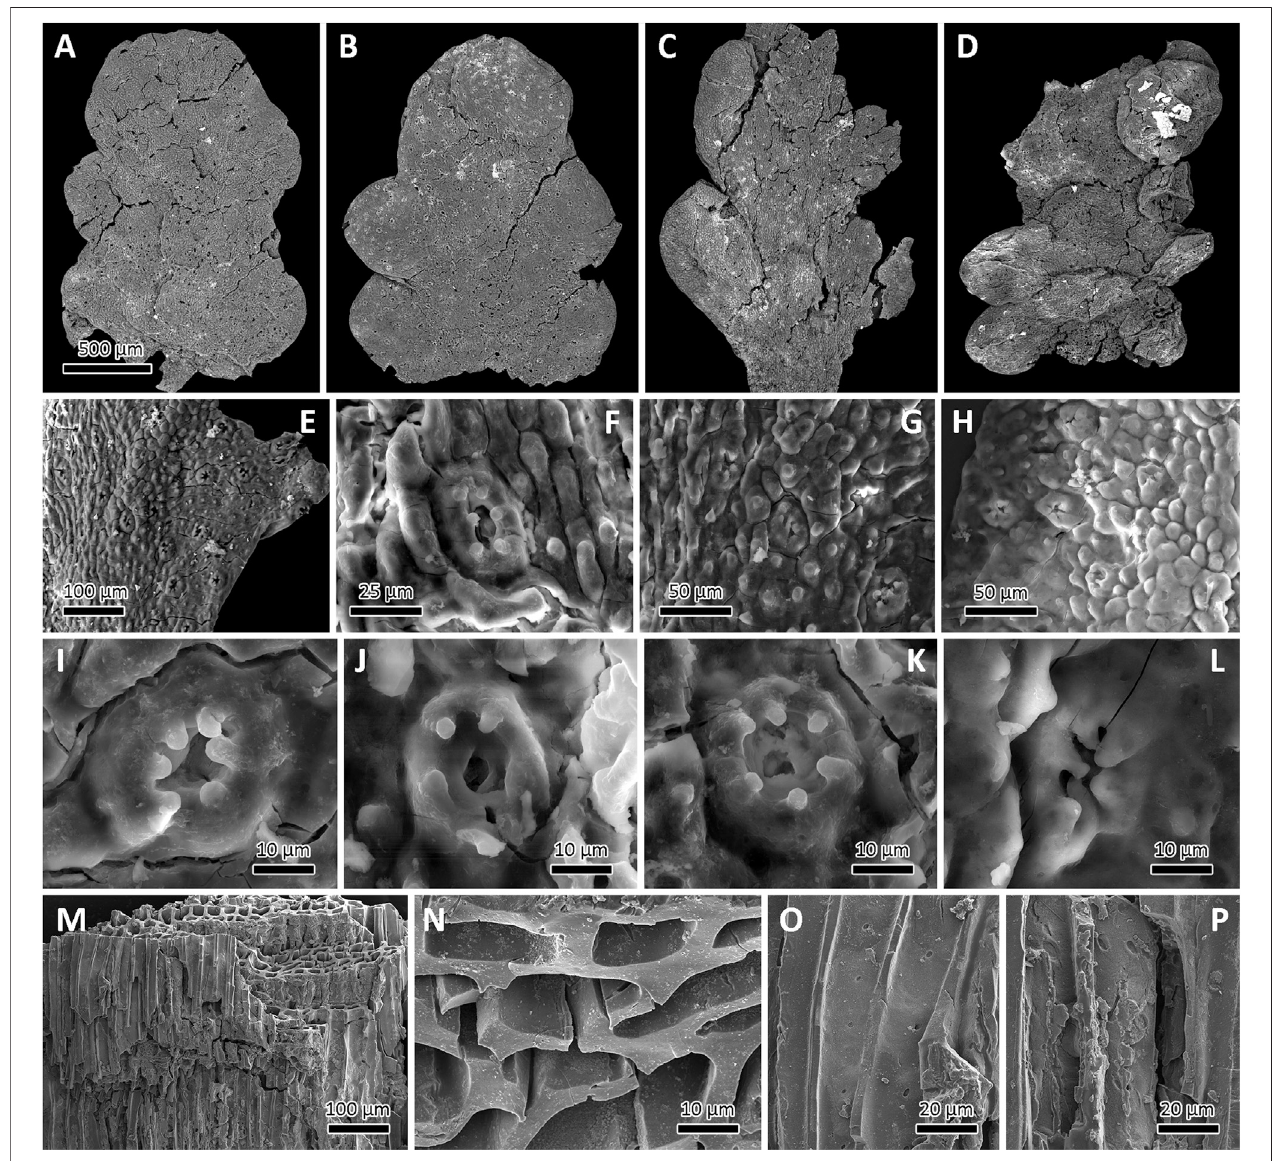
FIGURE 5 | Scanning electron microscopy images of epidermal anatomy of Germaropteris martinsii from the upper Permian Kayitou Formation of Southwest China. (A – D) Charcoali fi ed specimens showing various morphologies from less mature to mature pinnae. (E) Epidermal structure of the rachis and pinnule, from left to right;notethescatteredstomatalcomplexes. (F) Slightlyelongatestomatalcomplexandconspicuouslylongitudinallyelongatedepidermalcellsontherachis. (G) Middle part of a pinnule showing stomatal complex with a rounded outline; note the prominent papillated epidermal cells. (H) Margin of a pinnule showing the less prominent papillate epidermal cells. (I – L) Stomatal complexes; note the stomatal aperture overarched by the long papillae of the surrounding subsidiary cells. (M) Overview of charred wood fragment collected from the studied level. (N) Detail of (M) showing homogenized cell walls. (O) Detail of (M) highlighting the cell-wall homogenization and uniseriate pits on the radial tracheid walls. (P) Detail of (M) highlighting the cell-wall homogenization and biseriate pits on the radial tracheid walls. Scale bar in (A) also applies to (B – D) .